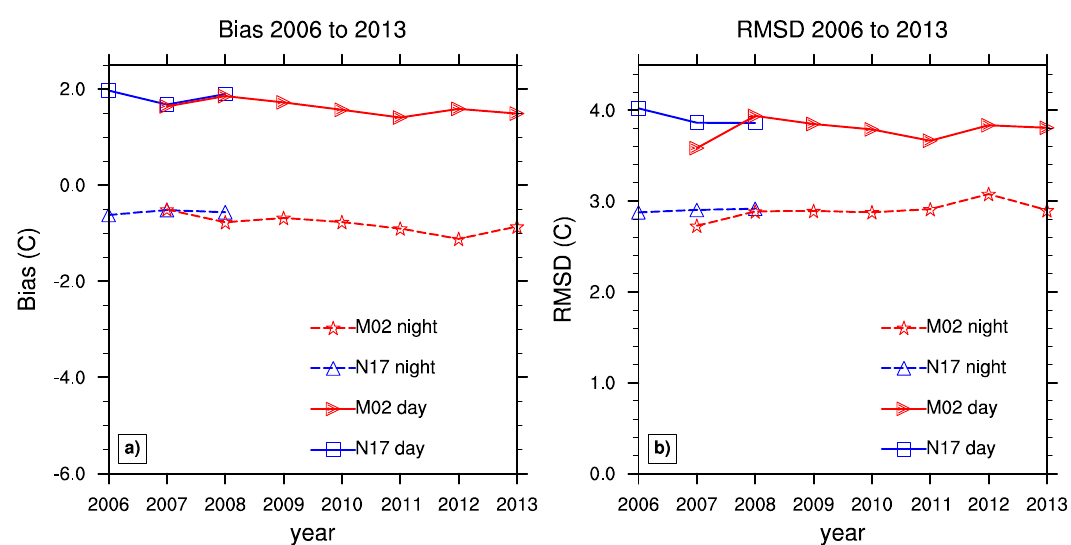
Figure 5. Annual mean bias ( a ) and RMSD ( b ) of HIRS M02 and N17 SATs (in °C, both day and night). Bias is defined here as HIRS minus USCRN.